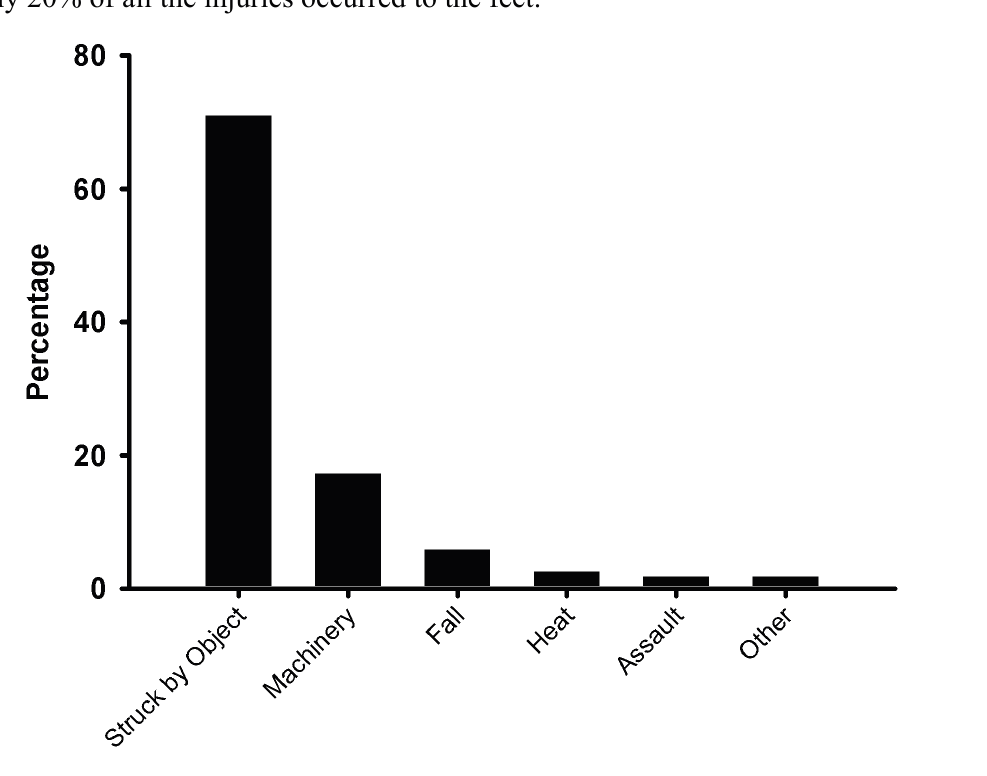
Figure 3. Self-reported causes of injury (from the 121 injury events) by the artisanal and small-scale gold miners from the Tarkwa (Ghana) study